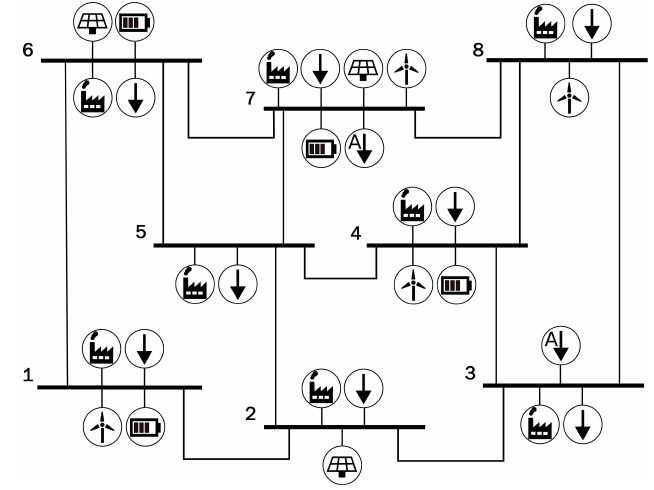
Figure 6. Transmission system scheme.